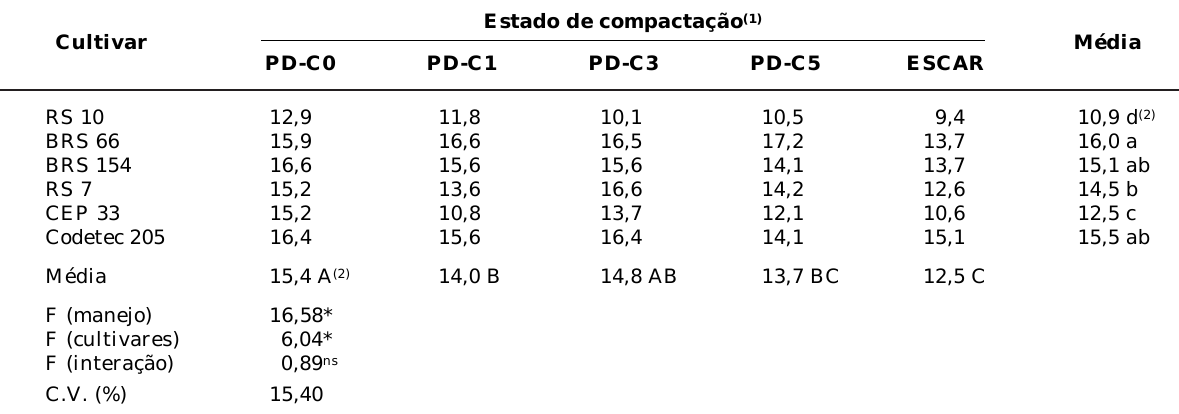
Figura 3. Variação da resistência com a profundi- dade do Latossolo Vermelho distroférrico, em quatro estados de compactação e em área Figura 2. Relação entre a macroporosidade (Macro) escarificada, com teor médio de água de e a densidade do solo (Ds) de um Latossolo Vermelho distroférrico. Quadro 2. Número de plantas de seis cultivares de soja por metro linear em um Latossolo Vermelho distroférrico sob dois sistemas de manejo e quatro estados de compactação e